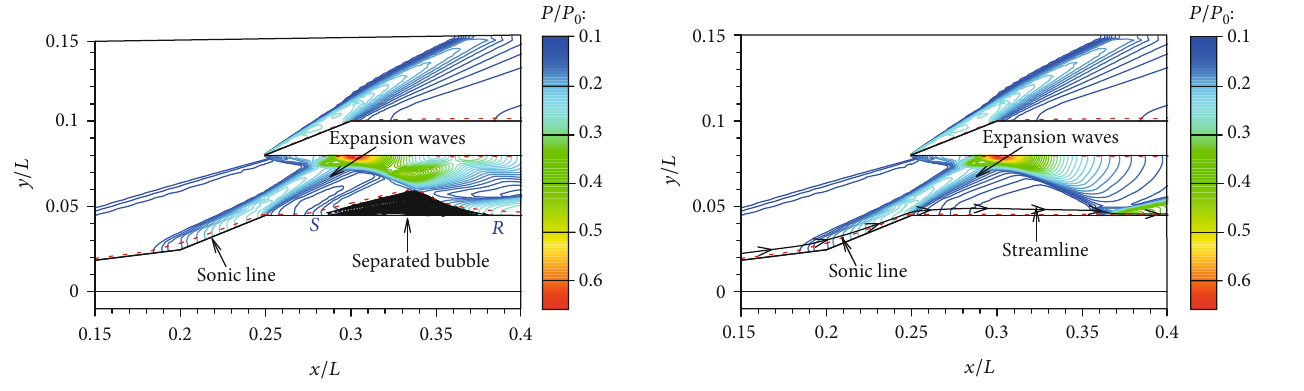
Figure 20: Flow fi eld structure in hypersonic inlet without MHD control.